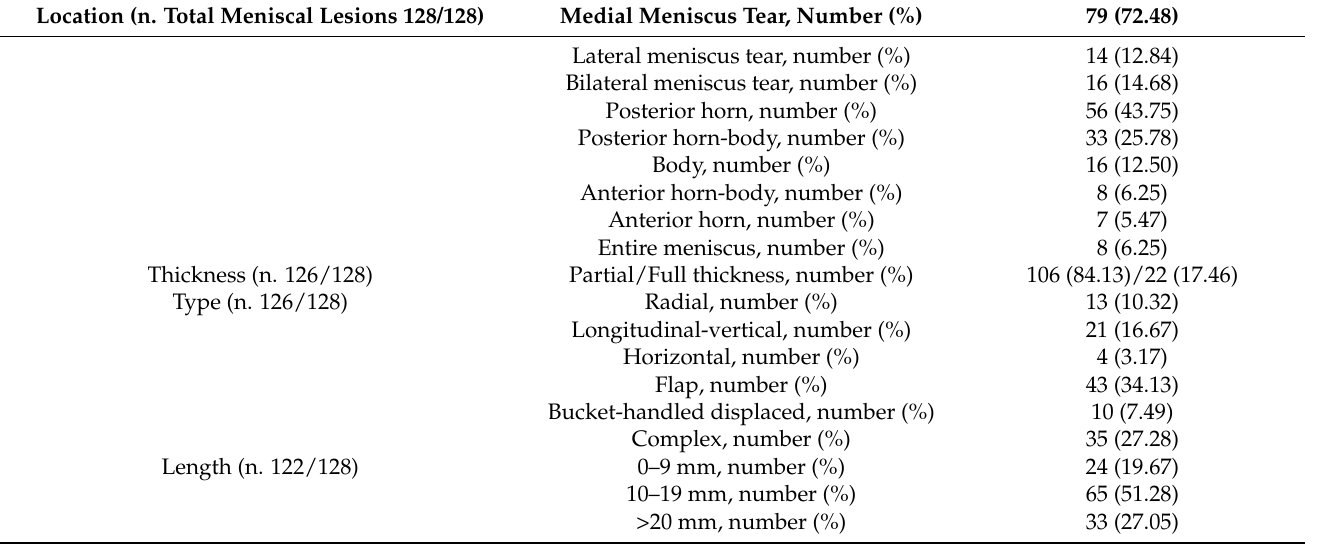
Table 2. Meniscus Tear Characteristics (N =